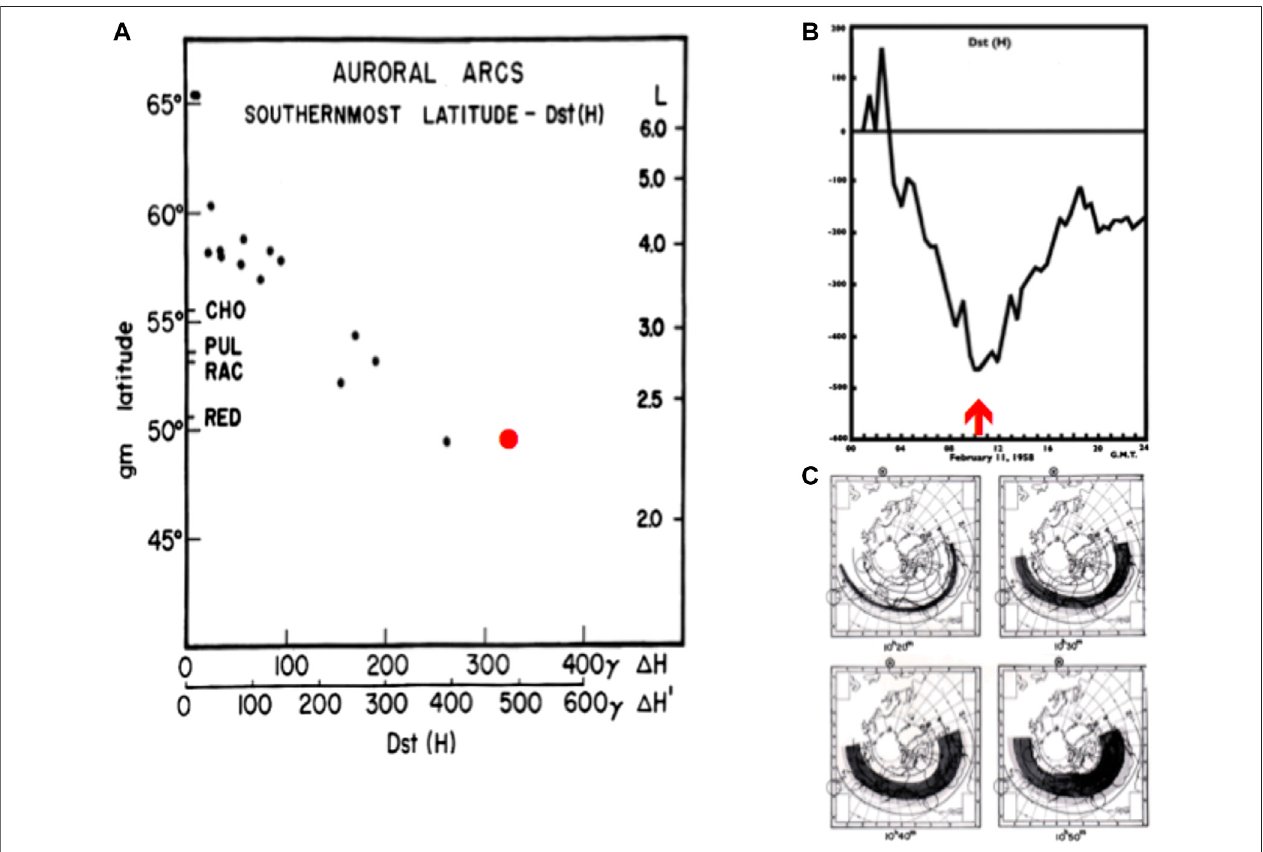
FIGURE 7 | (A) The relationship between the location of the initially brightening of an arc (substorm onset) and the Dst index during geomagnetic storms (Akasofu and Chapman, 1963c). The red dot case occurred during an intense geomagnetic storm of February 11,1958. (B) The Dst index during the February 11, 1958. The red arrow shows the onset of an intense substorm shown in (C)